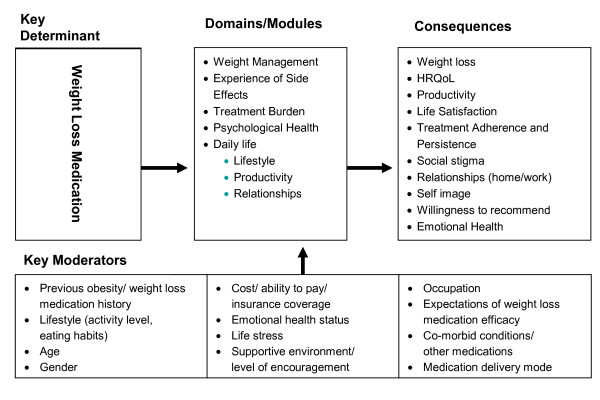
Theoretical Model.